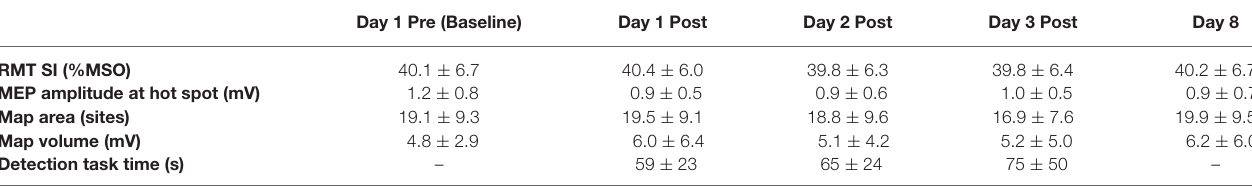
TABLE 1 | Group data for TMS parameters and the attention task